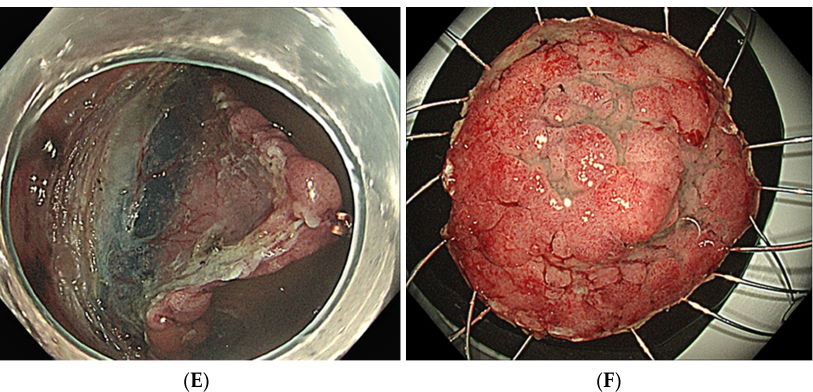
Figure 2. Method of S-O clip-assisted ESD. ( A ) An endoscopic examination with narrow-band imaging and 0.4% indigo carmine is conducted before ESD; ( B ) A circumferential incision of the mucosal layer is performed; ( C , D ) The S-O clip is attached to the proximal edge of the lesion, and another clip is used to grasp the nylon loop and pull one in front to fix to the colon wall opposite the lesion; ( E ) A counter-traction force allows good visualization of the submucosal cutting line; ( F ) Resected specimen.